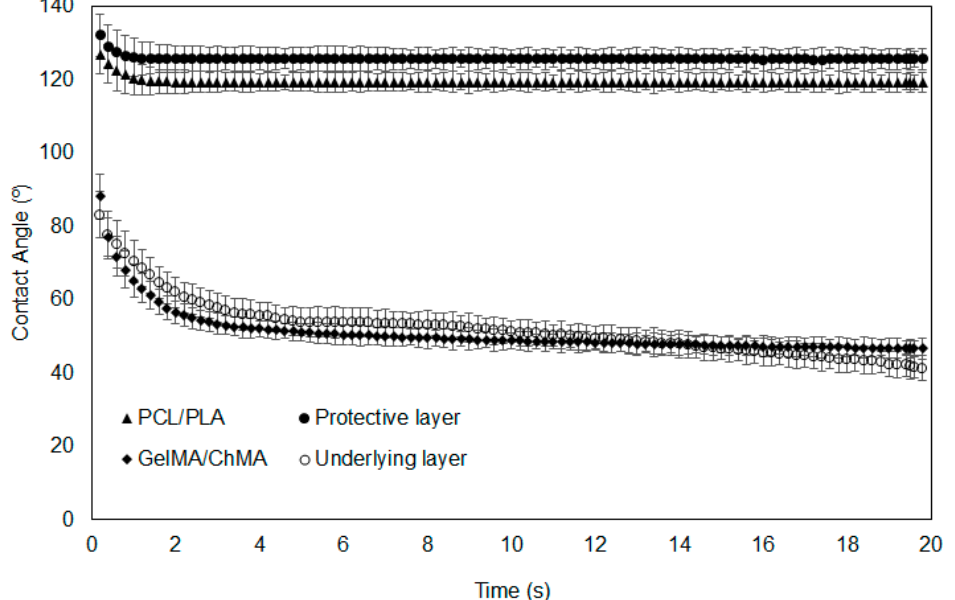
Figure 5. Determination of water contact angles at the surface of the nanofibrous membranes along time.